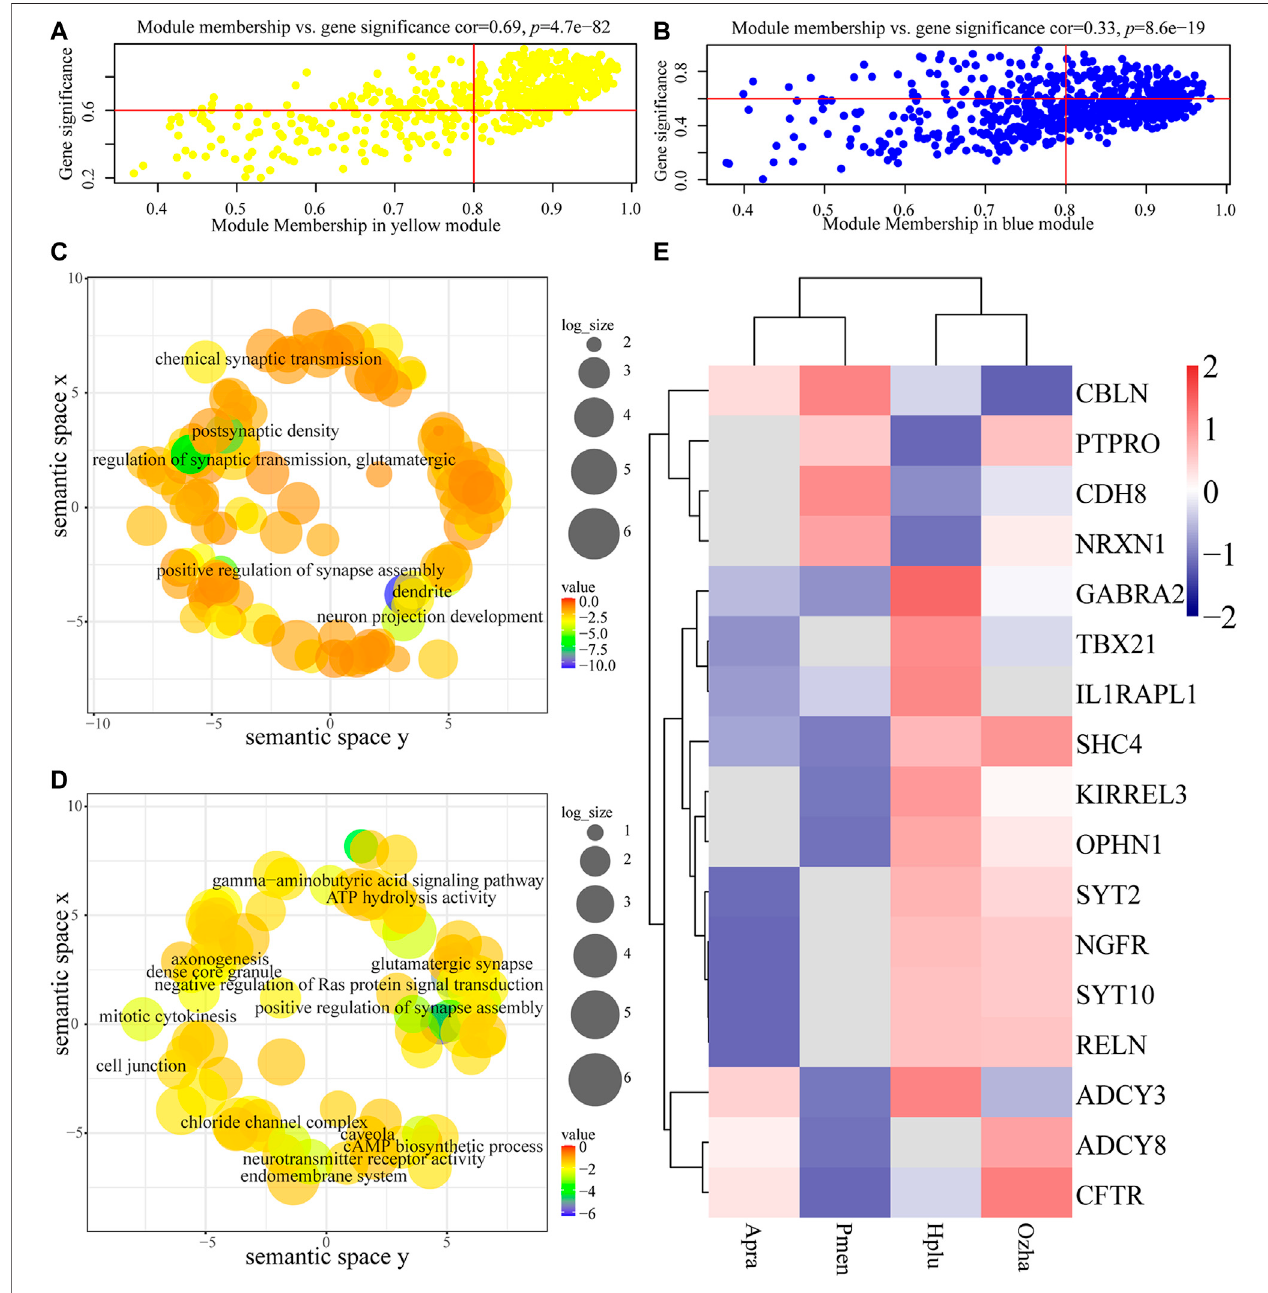
FIGURE5| AnalysisoftheaquaticMOS(yellow)moduleandthenon-aquaticMOS(blue)module. (A,B) The x -axisismodulemembershipandthe y -axisstandfor gene signi fi cance. Gene signi fi cance (GS) was calculated to measure the correlation between habitat and expression pro fi les and module membership (MM) was calculatedtomeasurethecorrelationbetweenMEandexpressionpro fi les. (A) Scatterplotsofgenesigni fi cance(GS)forhabitattraitsversusmodulemembership(MM)in theaquaticMOSmodule. (B) Scatterplotsofgenesigni fi cance(GS)forhabitattraitsversusmodulemembership(MM)inthenon-aquaticMOSmodule. (C,D) Each termwasassignedxandycoordinatesandmoresemanticallysimilarGOtermswerecloserintheplot.ThesizeofthecirclesindicatesthenumberofchildGOterms. (C) GO enrichment analysis of genes in the aquatic MOS module was visualized using REVIGO. (D) GO enrichment analysis of genes in the non-aquatic MOS module was visualized using REVIGO. (E) The expression of olfactory-related genes in the two modules.